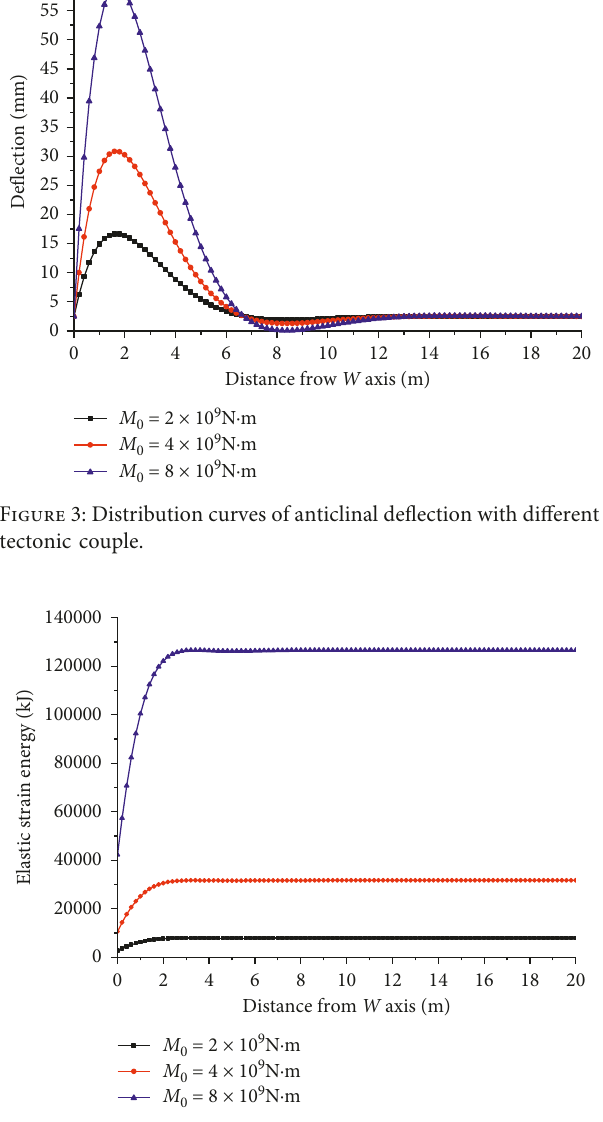
Figure 4: Distribution curves of anticlinal elastic strain energy with different tectonic couple.